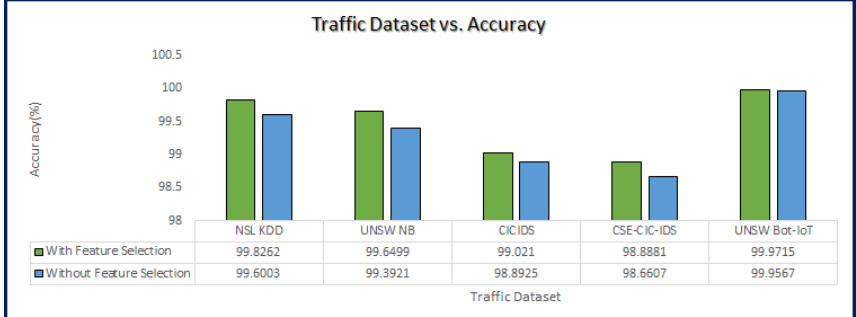
Figure 7. Traffic Dataset vs. Accuracy with respect to features. Table 5. State-of-the-Art analysis of proposed LPCOCN using UNSW Bot-IoT dataset. Approach/Year Accuracy